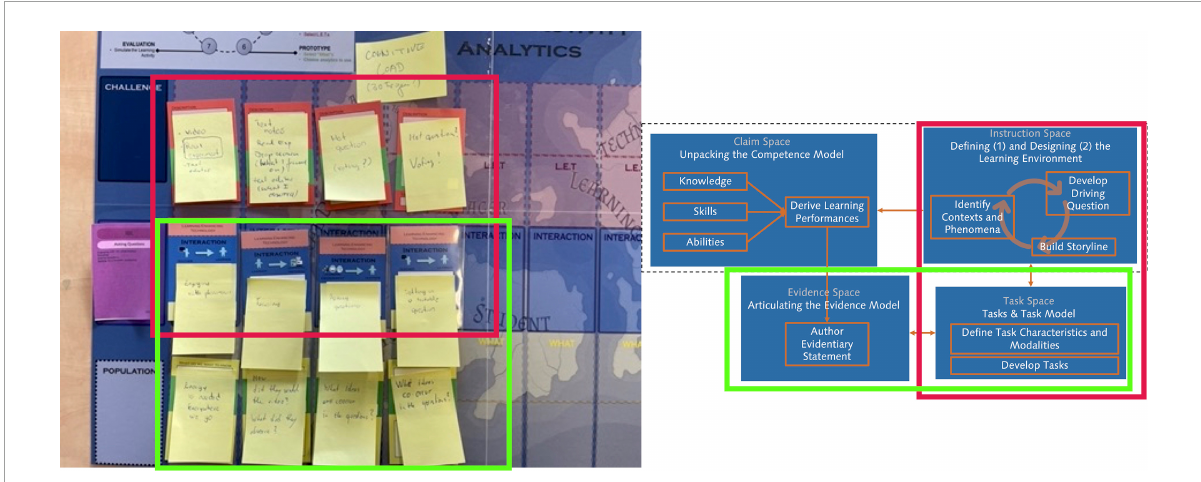
FIGURE8 FoLA 2 use example for the scientific practice of asking questions, red and green boxes indicate how FoLA 2 supports alignment between different spaces in evidence-centered design.